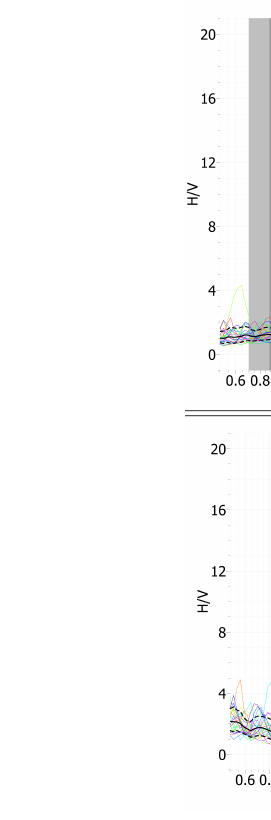
Figure 19. HVSR plots of acceleration recordings for lower floor old building (top left figure), ground floor old building (top right figure), first floor old building (bottom left figure) and second floor old building (bottom right